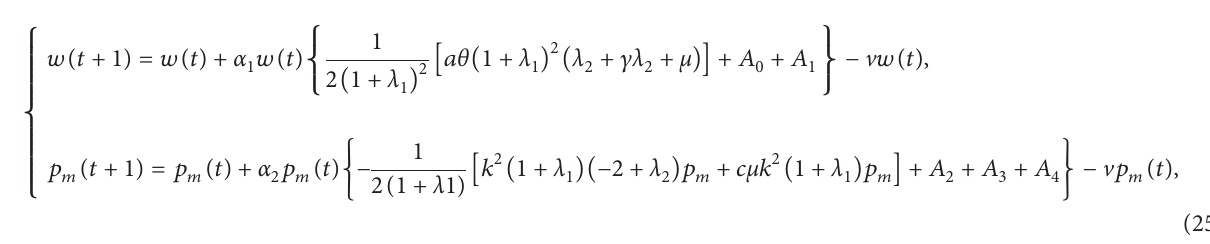
� 0 . 02 and α � 0 . 04. (a) v � 0 . 2. (b) v � 0 . 1 2